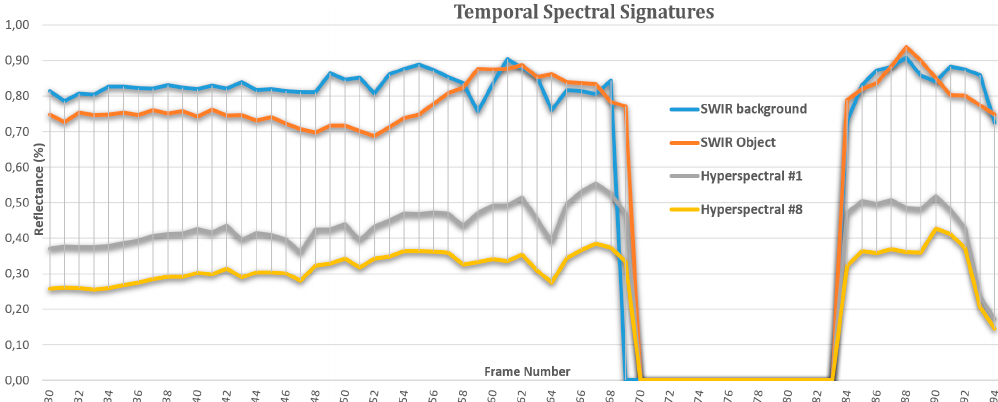
Figure 7. The temporal spectral signatures of both the target and the background are calculated and employed during the target recognition and verification step.